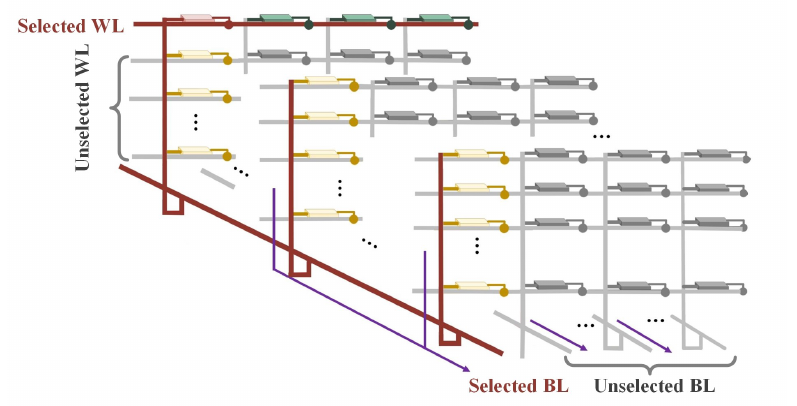
Figure 4. Spice model of the novel 3-D VRRAM array.